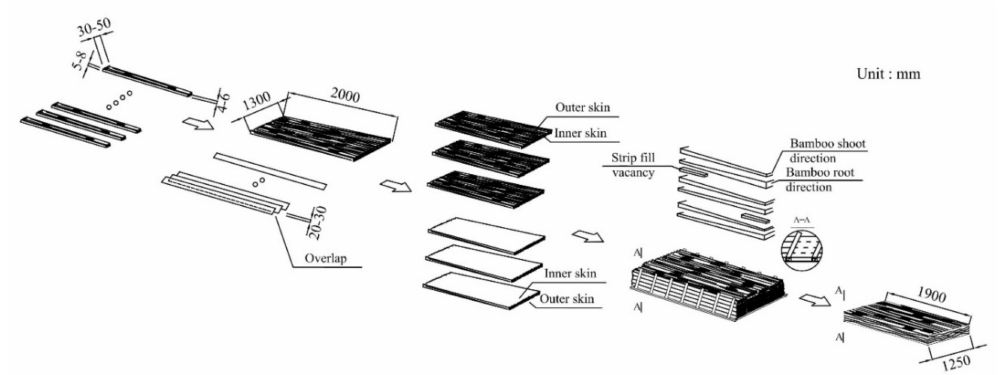
Figure 3. Schematic representation of elements of the mat formation process for BFC: strip dimensions, layer formation, interlayer formation, mat assembly and consolidated